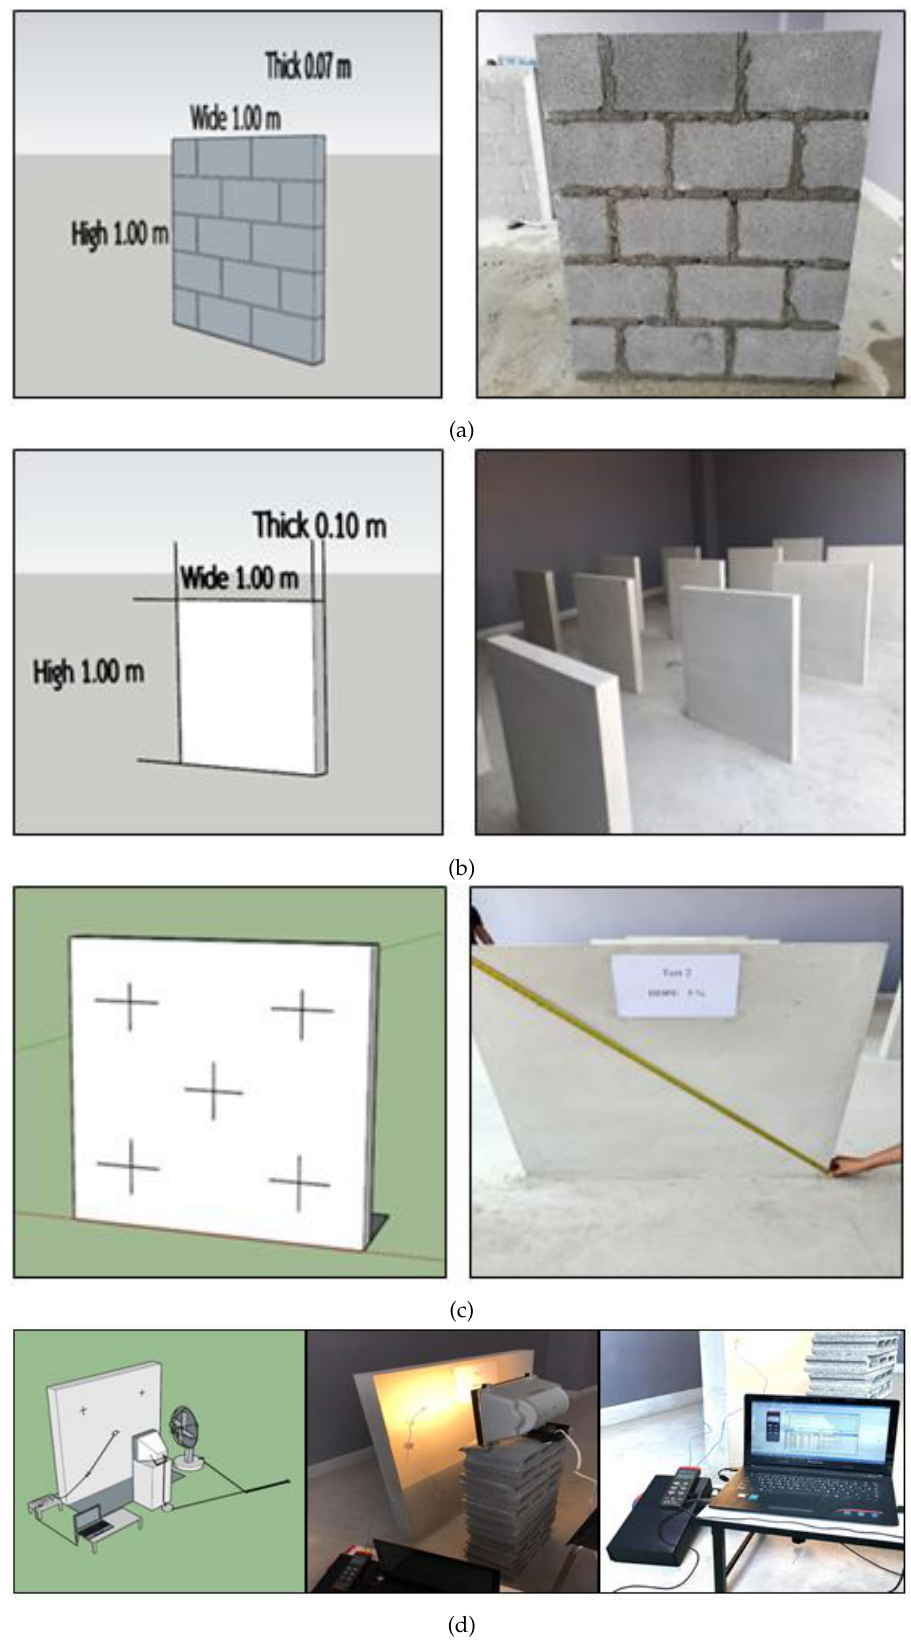
Fig. 4. Heat transfer testing for the mortar with plastic waste. (a) wall construction; (b) plastering wall with the mortar blended plastic waste; (c) 5 test point design (d) heat transfer